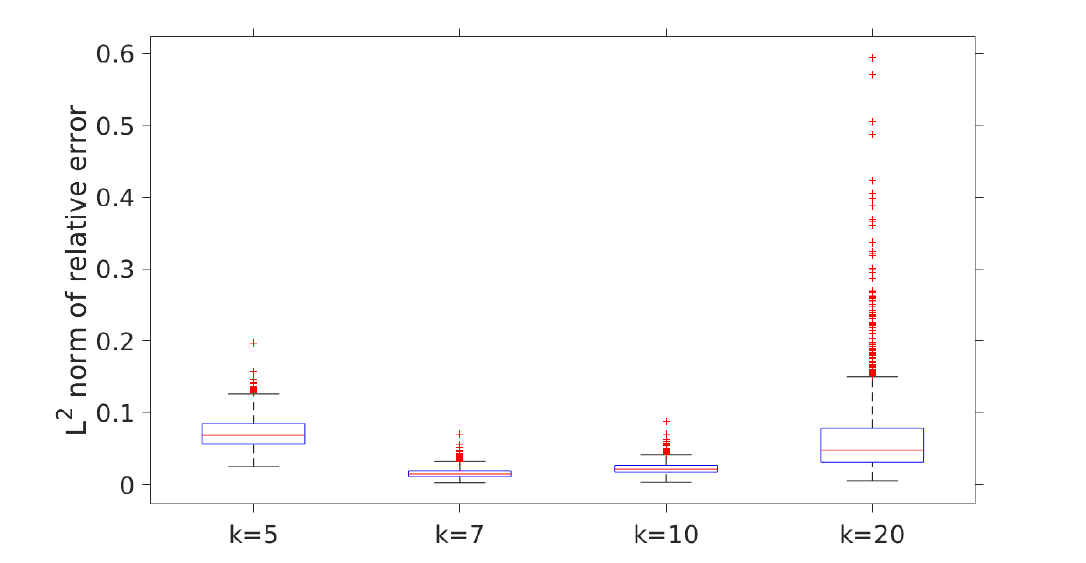
Figure 2. Distribution of the relative errors of the 2000 evaluation data sets for different wavenumbers. The central mark on each box indicates the median, and the bottom and top edges of the box indicate the 25th and 75th percentiles, respectively. The whiskers extend to the most extreme data points not considered outliers, and the outliers are plotted individually using the ‘+’